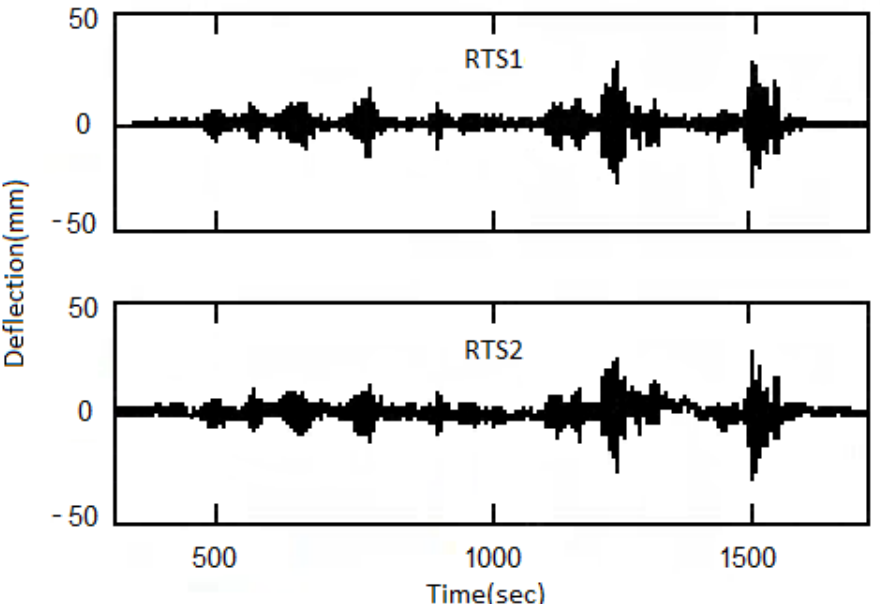
Figure A1. Lateral deflections of the bridge during certain excitation events of the 2009 survey recorded by two different robotic theodolites (RTS) sighting at reflectors at the two sides of the bridge, at its midspan. Amplitude of deflections is similar for the two instruments, with a maximum of the order of ~25 mm. Recorded apparent deflections during the intervals of no excitation define the static noise level of the RTS, 1–2 mm [35].